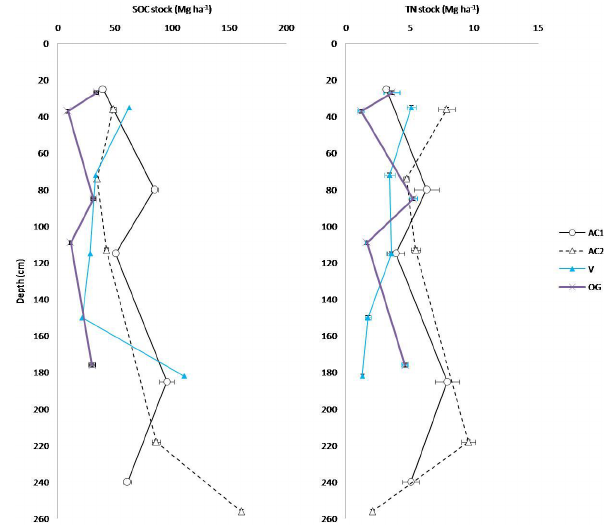
Figure 4. Depth distribution of SOC stock and TN stock under arable crop (AC1), arable crop 3 Fig. 4. Depth distribution of SOC stock and TN stock under arable (AC2), Vineyard (V) and Olive groves (OG). Data are means ± SD (n * = 5, 7, 5, 10). * 4 crop (AC1), arable crop (AC2), vineyard (V) and olive groves (OG). Sampling size. 5 Data are means ± SD ( n ∗ = 5, 7, 5, 10). ∗ Sampling